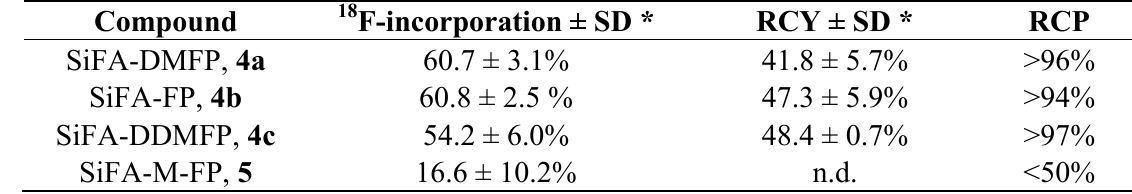
Table 5. Radiolabeling of 4a–c and 5 , 10 nmol, labeling method (b) in acetonitrile.